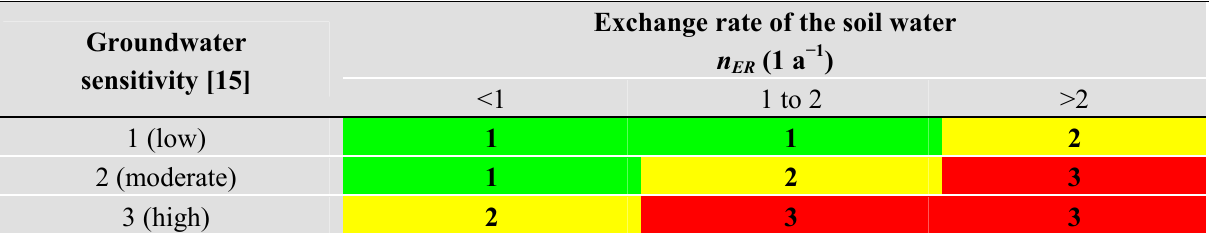
Table 10. Assessment matrix for the estimation of sensitivity E: Sensitivity towards groundwater pollution, valid for Israel, the West Bank and Gaza. For Jordan, the final sensitivity grade E was assessed based on the exchange rate n ER